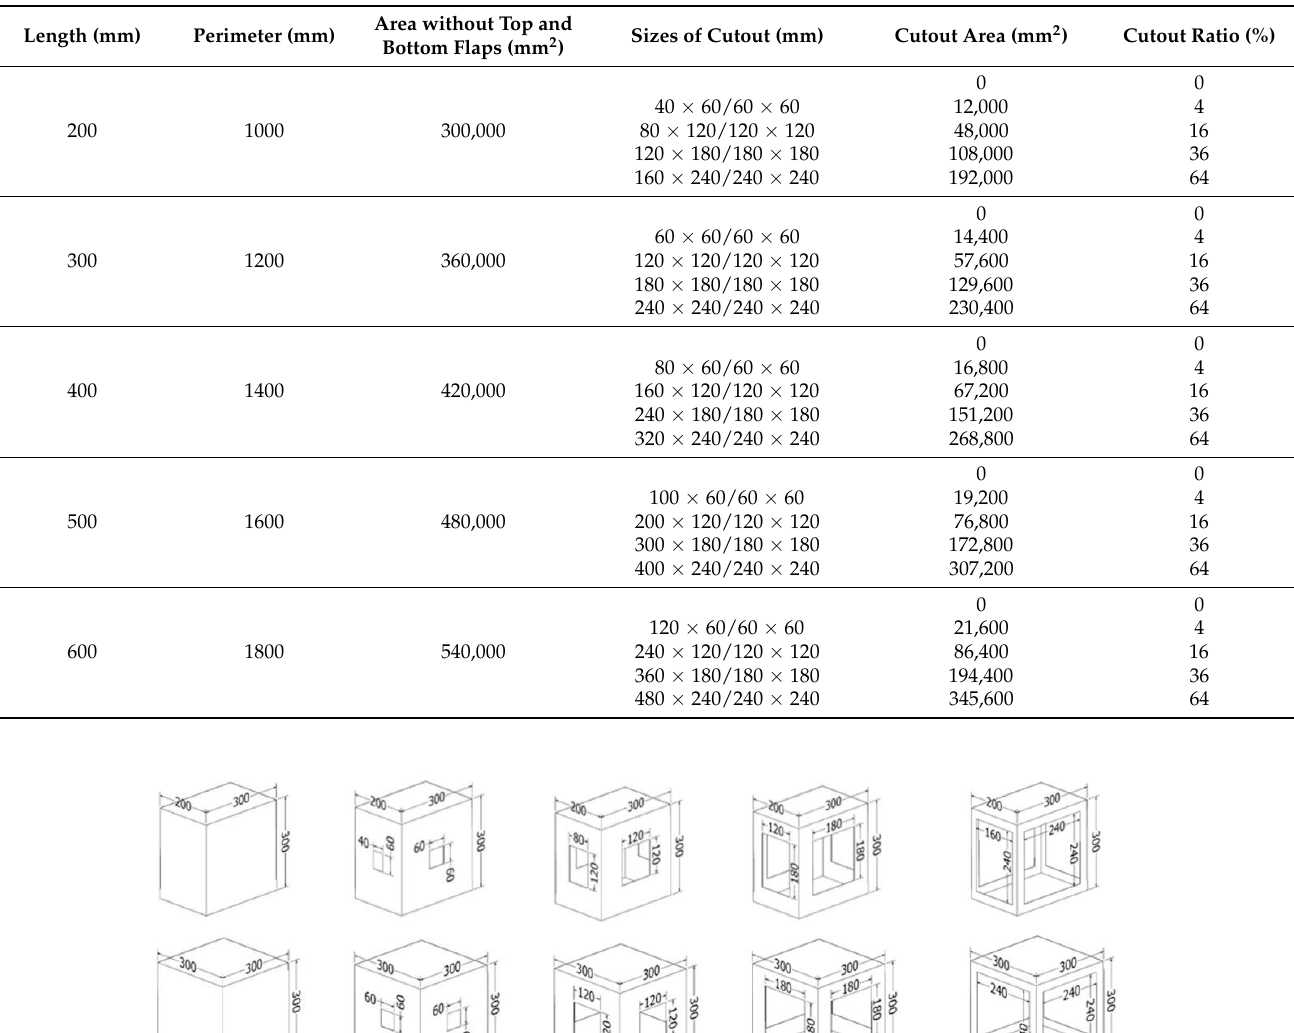
Table 2. Configuration for dimensions of samples for this study (same width and height of 300 mm).